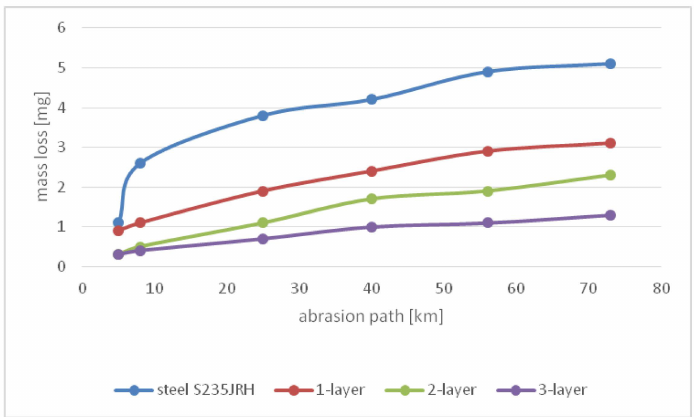
Figure 4. Course of wear for hardfacing material E 518